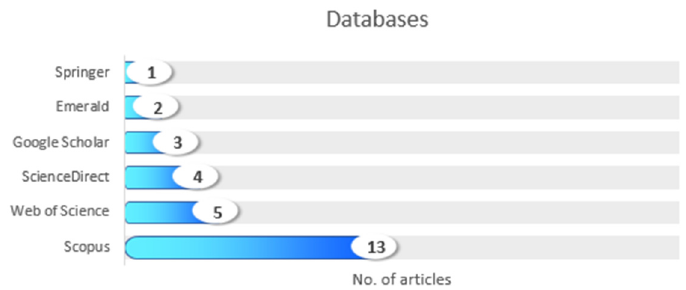
Figure 3. Articles by database.